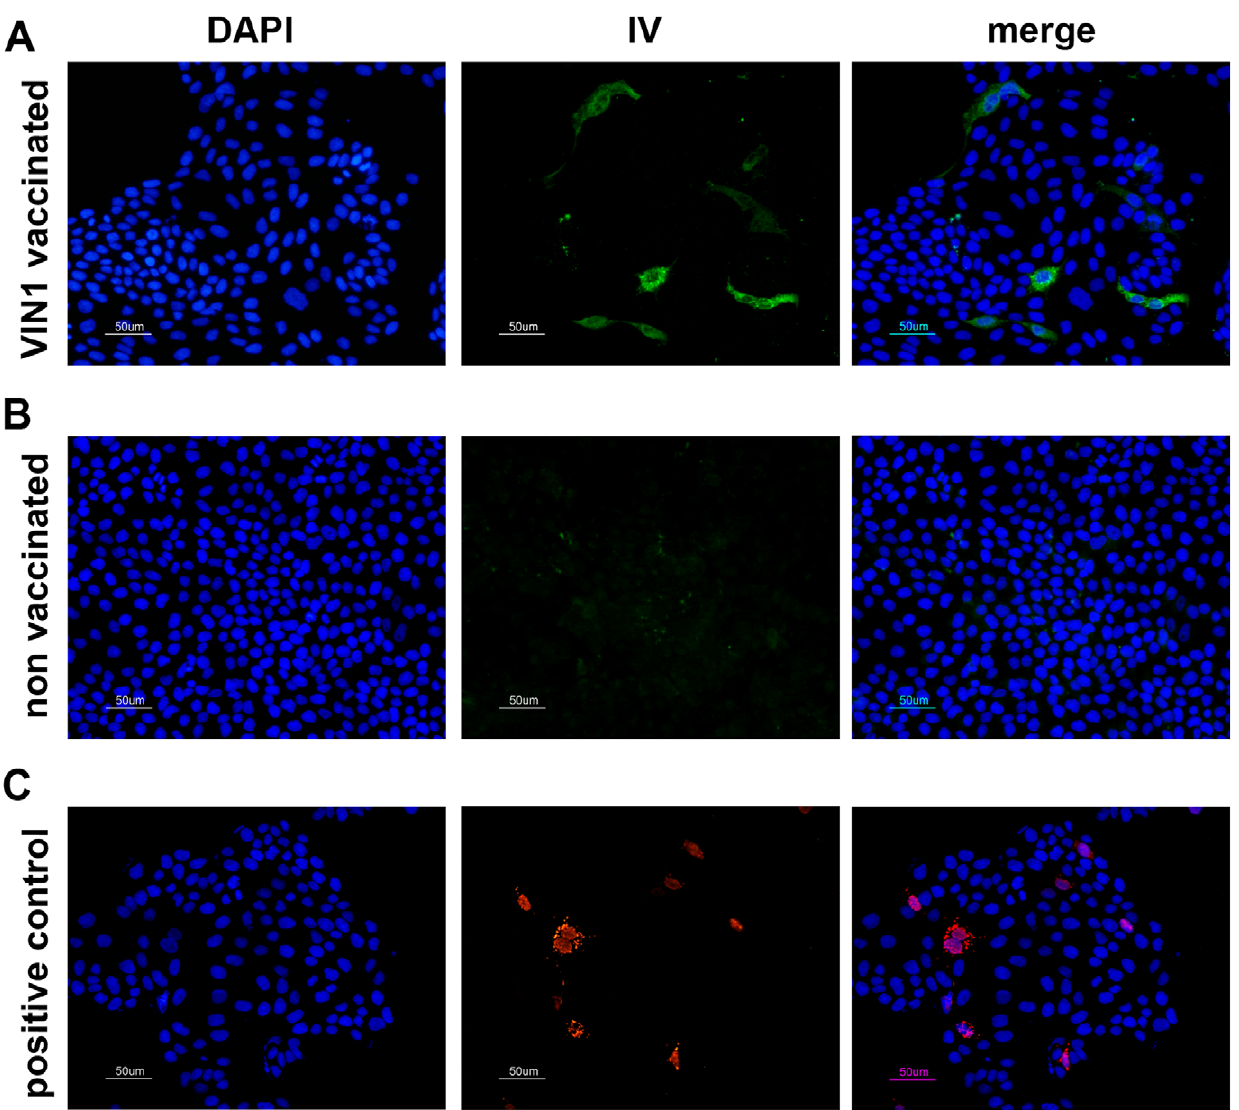
Figure 4. VIN1-sera recognize pH1N1 virus invitro. Indirect immunofluorescence of pH1N1-infected MDCK cells at 16 hpi using as primary antibody: (A) the serum from one pig (representative of the group), immunized three times with VIN1-peptides; (B) the serum from one negative control pig (representative of the group), immunized three times with PBS; and (C) A monoclonal antibody against the NS-1 protein was used as control for the infection (right